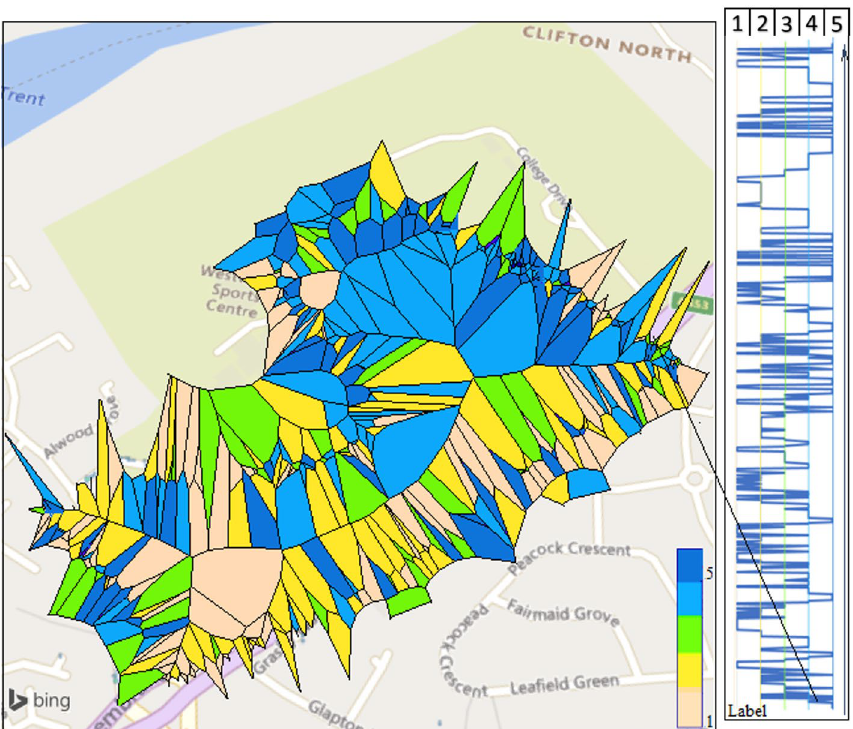
Fig. 12 (left) Voronoi overlay from one participant data. Each polygon represents one location trace tagged with a wellbeing label while collecting